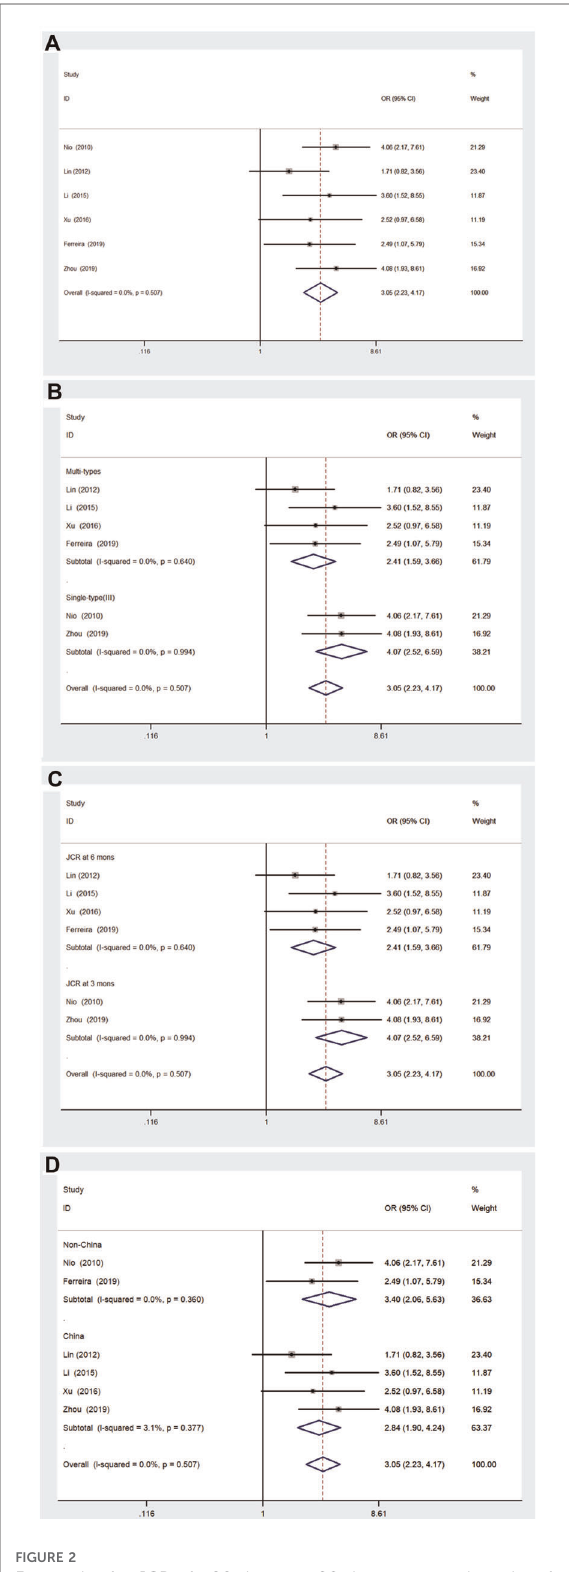
FIGURE 2 Forest plot for JCR of ≤ 90 days vs. >90 days group and results of subgroup analyses. ( A ) Forest plot for JCR. ( B ) Subgroup analysis based on biliary atresia type. ( C ) Subgroup analysis based on JCR at 3 vs. 6 months. ( D ) Subgroup analysis based on region. JCR, jaundice clearance rate.